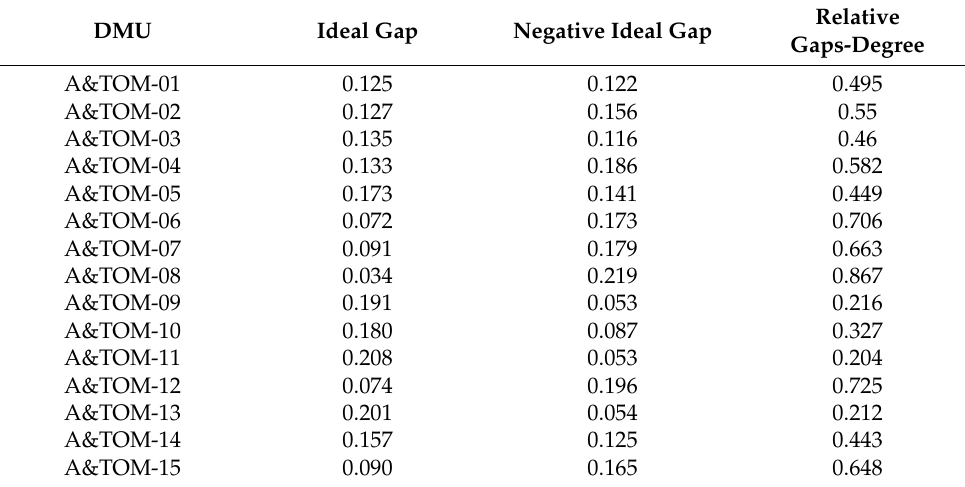
Table 14. Ideal, negative ideal and relative gaps-degree.